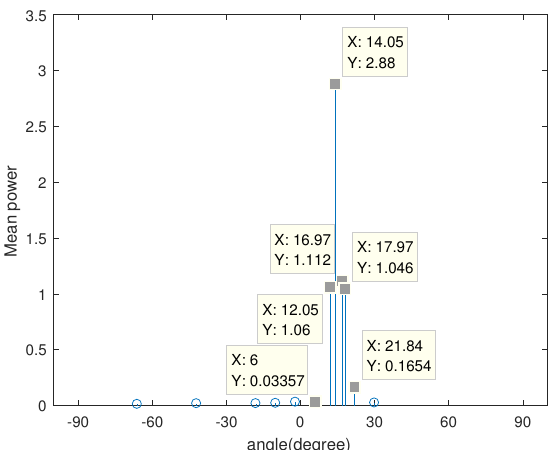
Figure 4. The spatial spectrum of GRDOA at the end of the initial estimation. Sources are from 14 ◦ and 17 ◦ with SNR = 10 dB.